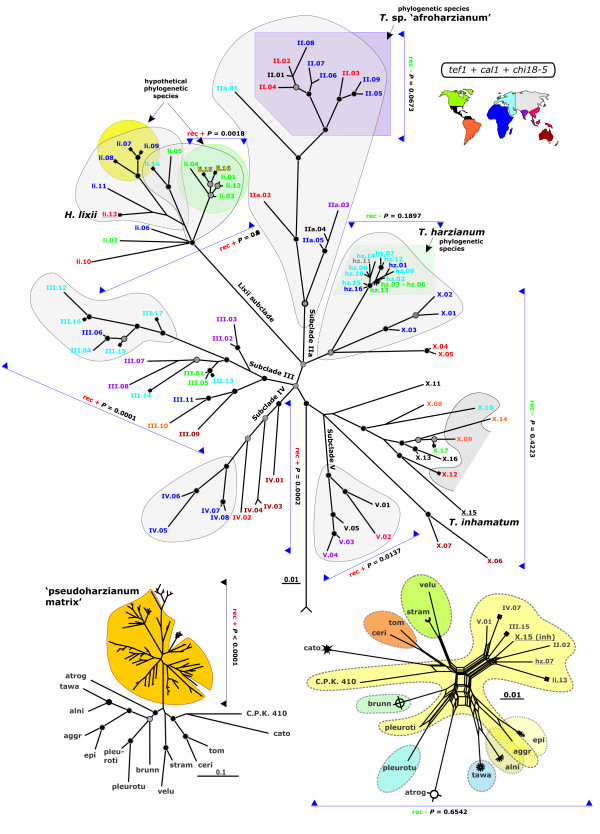
Multilocus phylogenetic map of H. lixii - T. harzianum species complex. The main body of the figure shows the radial Bayesian tree resulting from the analysis of the concatenated sequences of tef1, cal1 and chi18-5. Nodes supported by posterior probabilities (PP) > 0.94 and 0.89 < PP < 0.95 are indicated by black and grey dots respectively. Names of subclades, as used in the text, are written along the most internal branches leading to them. Full squares at OTUs indicate teleomorph isolates. The color code indicates the geographic region from which the isolates were obtained, as explained in the right top inset. Isolates with yellow color indicate uncertain geographic origin. The ex-type strains are underlined. The four putative phylogenetic species are indicated by rectangular and round backgrounds for agamospecies and holomorphic species, respectively. Isolates for which a recombination history was detected are grouped by irregular shape frames with grey background. Isolates used and results from the PHT test are shown by arrows and the respective P values, 'rec +' specifying positive recombination result and 'rec -'specifying no recombination detected. The left bottom inset shows the results from the same analysis when representative strains of the all studied H. lixii/T. harzianum and the representative strains of the Harzianum-Catoptron Clade were also included. The yellow background separates strains of the 'pseudoharzianum matrix'. Other symbols are used as above, but no geographic color code is applied. The right bottom inset shows the recombination network, determined by SplitsTree (NJ mode) from the combined dataset. Taxa with "harzianum"-like morphology are shown by a light yellow background and dotted lines; other anamorph morphologies are shown by different colours and dotted lines; individual teleomorph morphologies are indicated by different end symbols. Representative sequences for species from Harzianum-Catoptron Clade may be retrieved from NCBI Entrez search engine using [species strain locus] keywords.